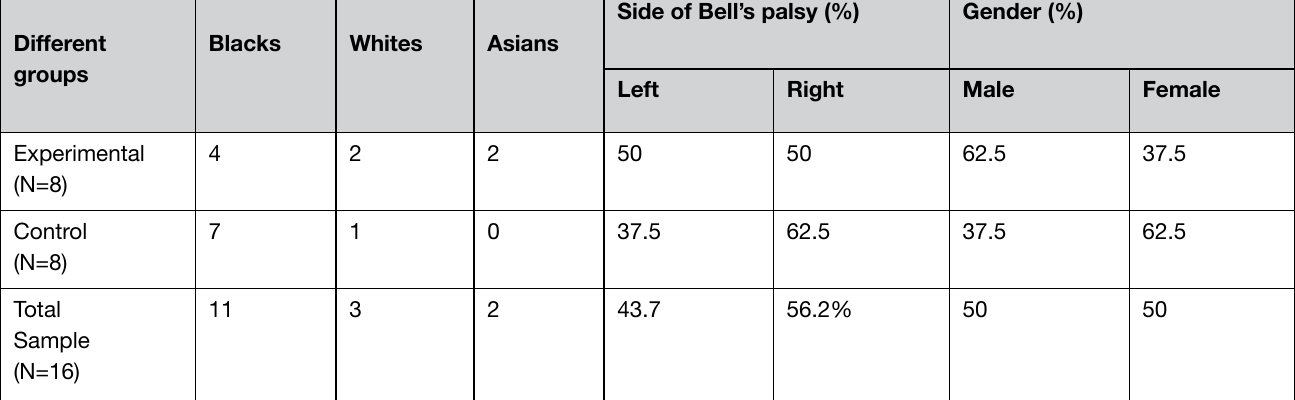
Table 2: individual recovery rates (%) using the FDi individual Recovery Rate per week Group